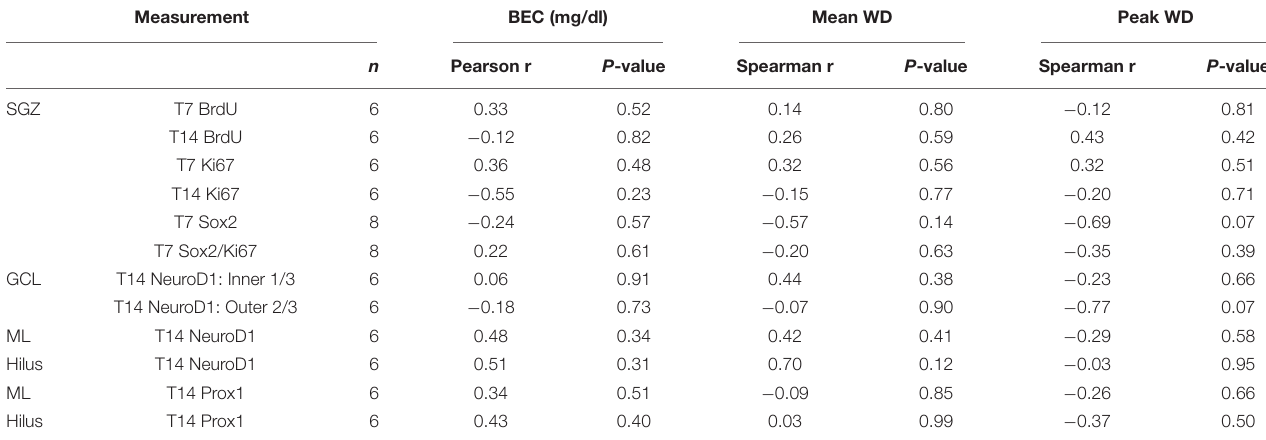
TABLE 3 | Correlations with BEC and withdrawal scores.